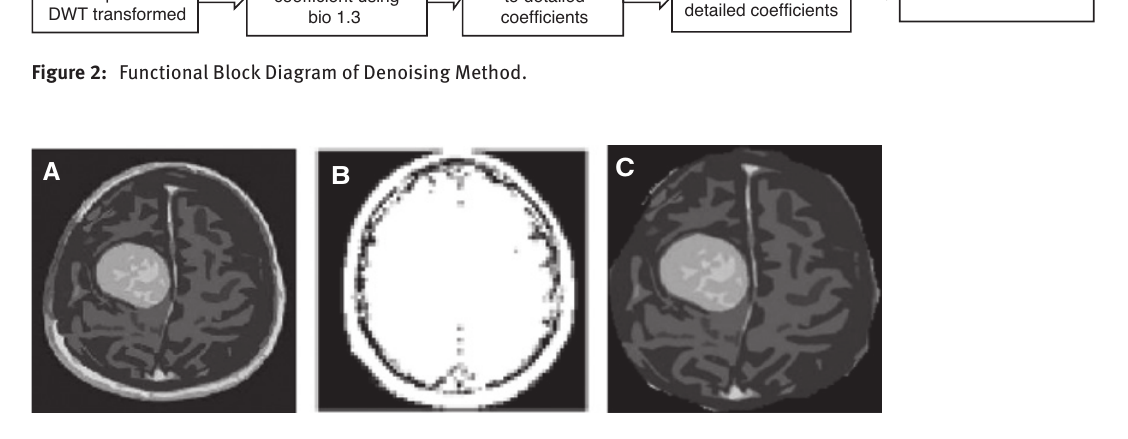
Figure 3: Brain Skull Stripping. (A) Real grey brain image, (B) binary image, and (C) skull-stripped